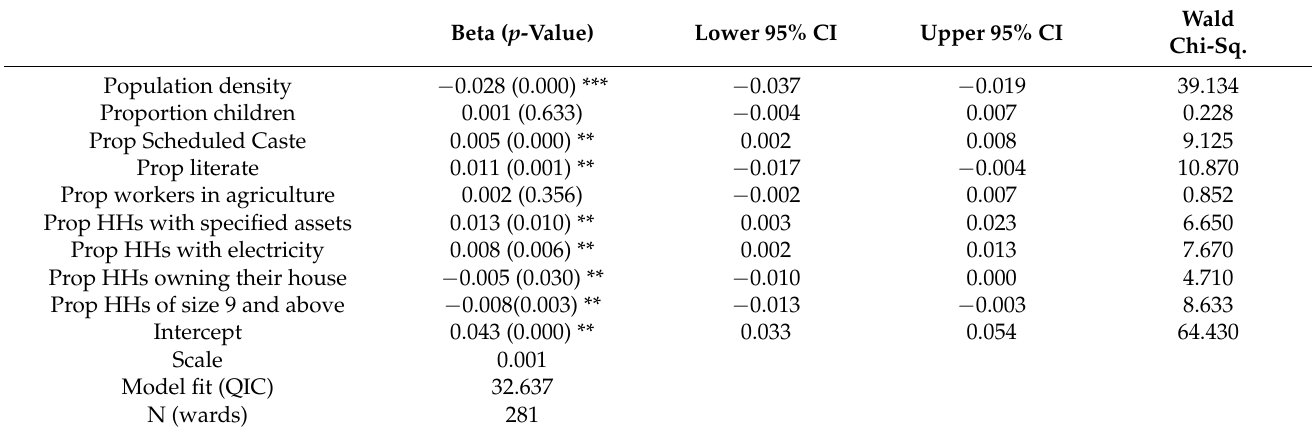
Table 4. Generalized estimating equation for predicting May NDVI using ward level socio-demographic variables.